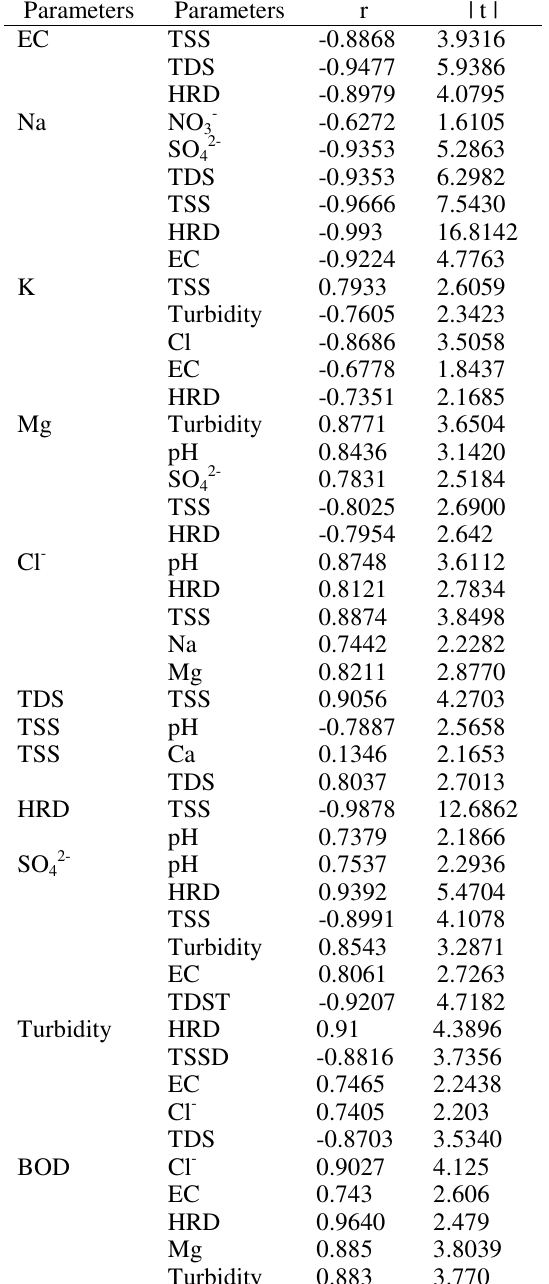
Table 2. .Different pair of correlations